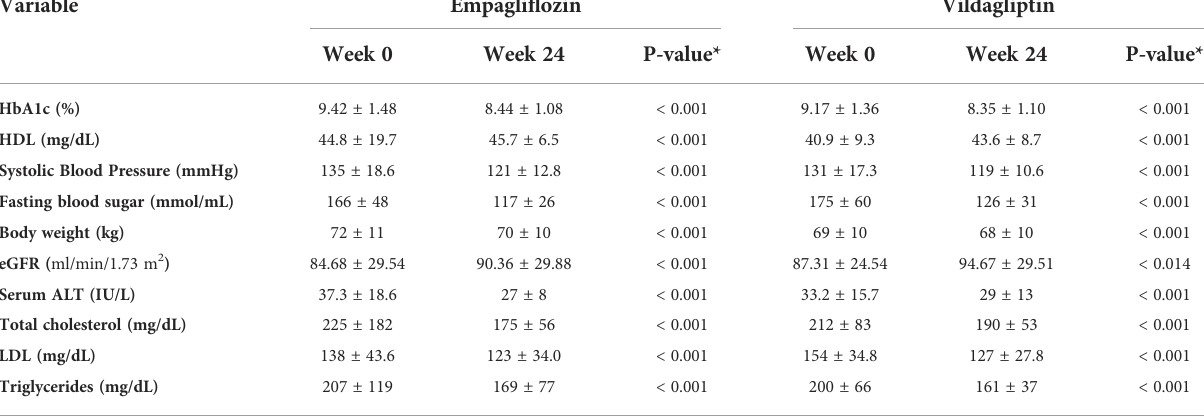
TABLE 3 Change in ef fi cacy and safety variables from baseline to week 24.